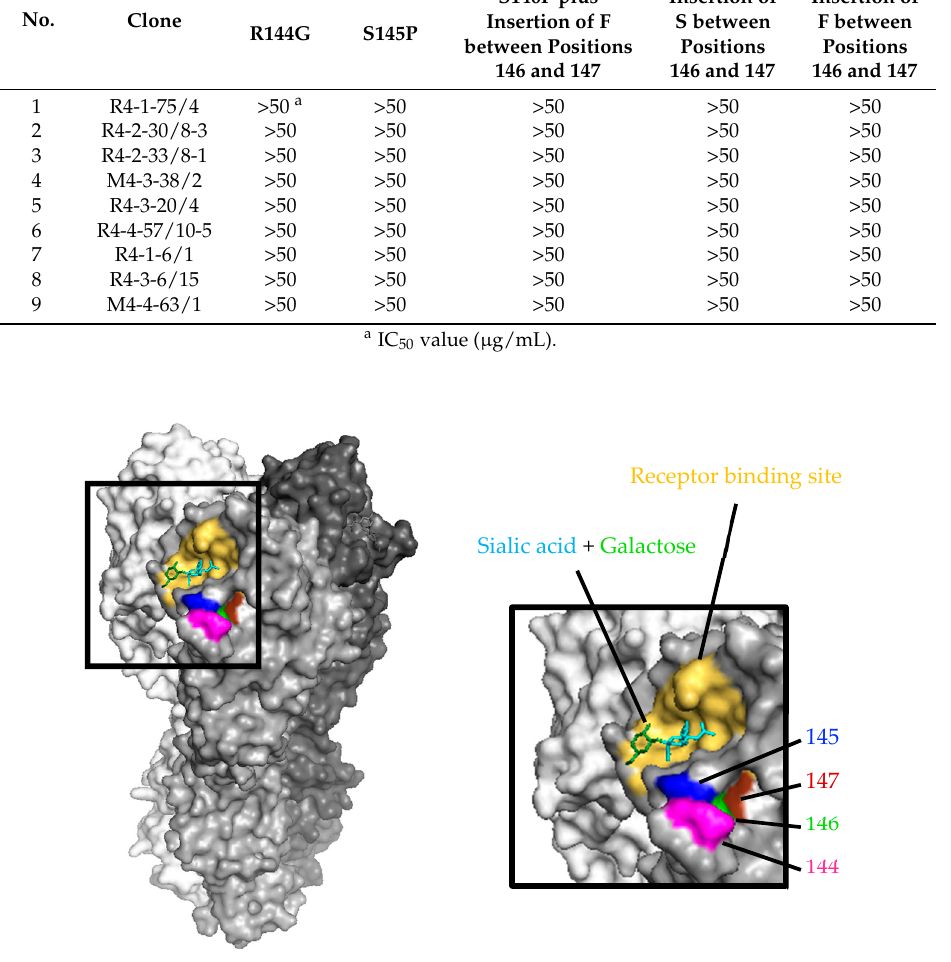
Figure 1. Mapping of escape mutations to HA. The amino acid mutation or insertion that was important to escape from our neutralizing mAbs are shown on the three-dimensional HA structure of A/duck/Egypt/10185SS/2010 (PDB ID: 5E2Z) using PyMOL. The sialic acid and galactose molecules are indicated by cyan and green, respectively. The receptor binding site (the range within a distance of 8 Å from the receptor molecule) is shown in yellow. The amino acids at positions 144–147 are indicated by magenta, blue, green, and brown, respectively.